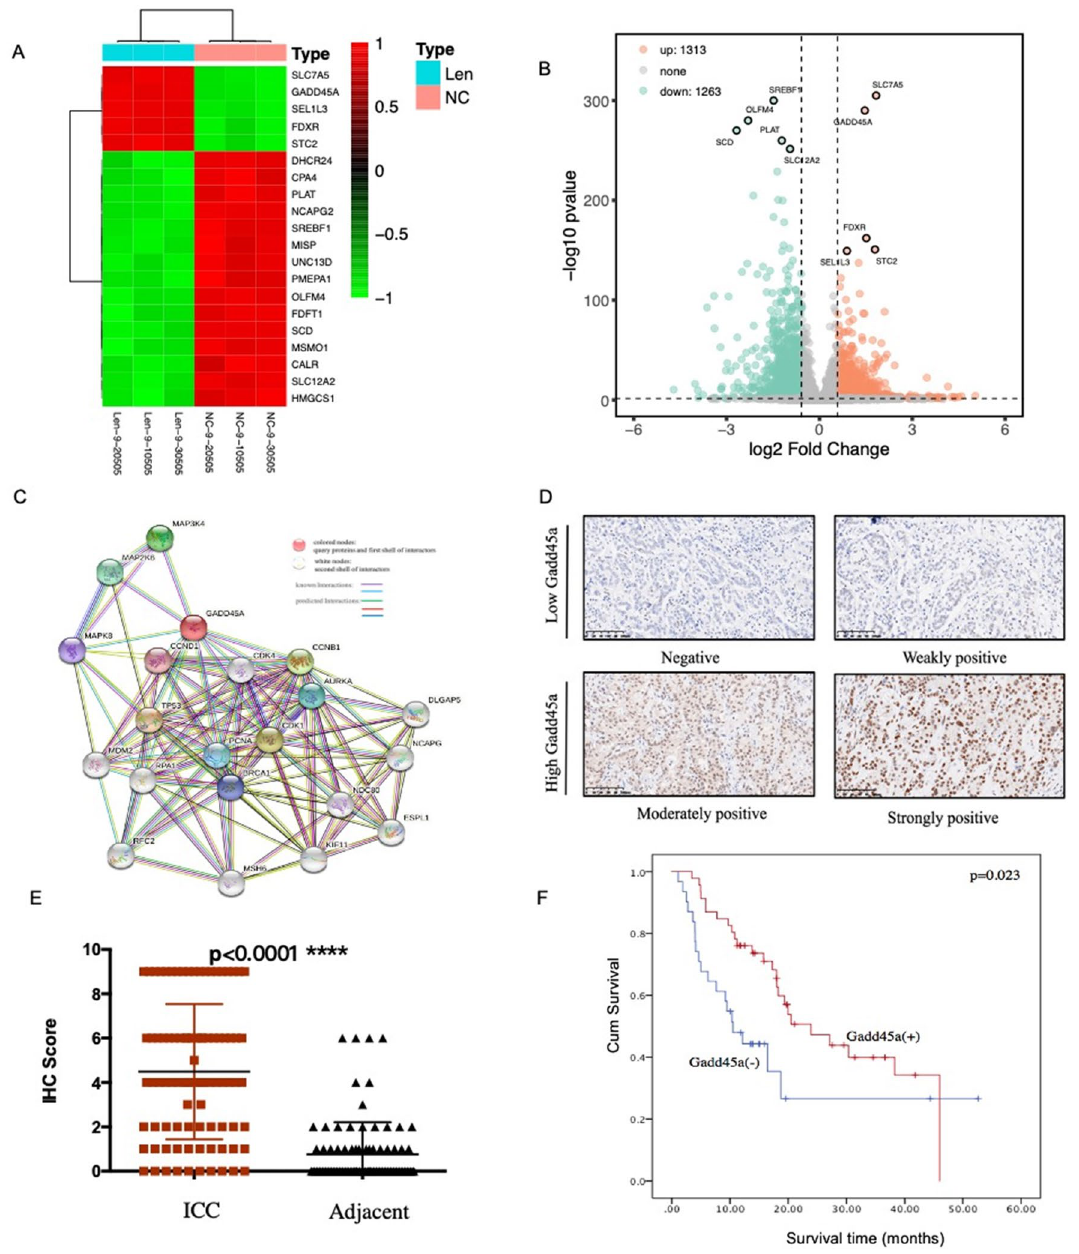
Fig. 4 Lenvatinib upregulates Gadd45a in vitro and in vivo, and Gadd45a expression is positively correlated with ICC prognosis. a and b Heatmap and volcano showing clustering of the top differentially expressed genes (determined by RNA sequencing) between ICC cells treated with lenvatinib (25 μM) and control cells; c protein–protein interaction network of Gadd45a, based on String; d representative images of IHC staining for Gadd45a in ICC (scale bar, 20 μm); e Gadd45a expression in ICC and adjacent normal tissues, as determined by the IHC score (n = 90 pairs, **** P < 0.0001); f the OS of patients with ICC was assessed based on Gadd45a expression using Kaplan–Meier analysis (n = 77, * P =